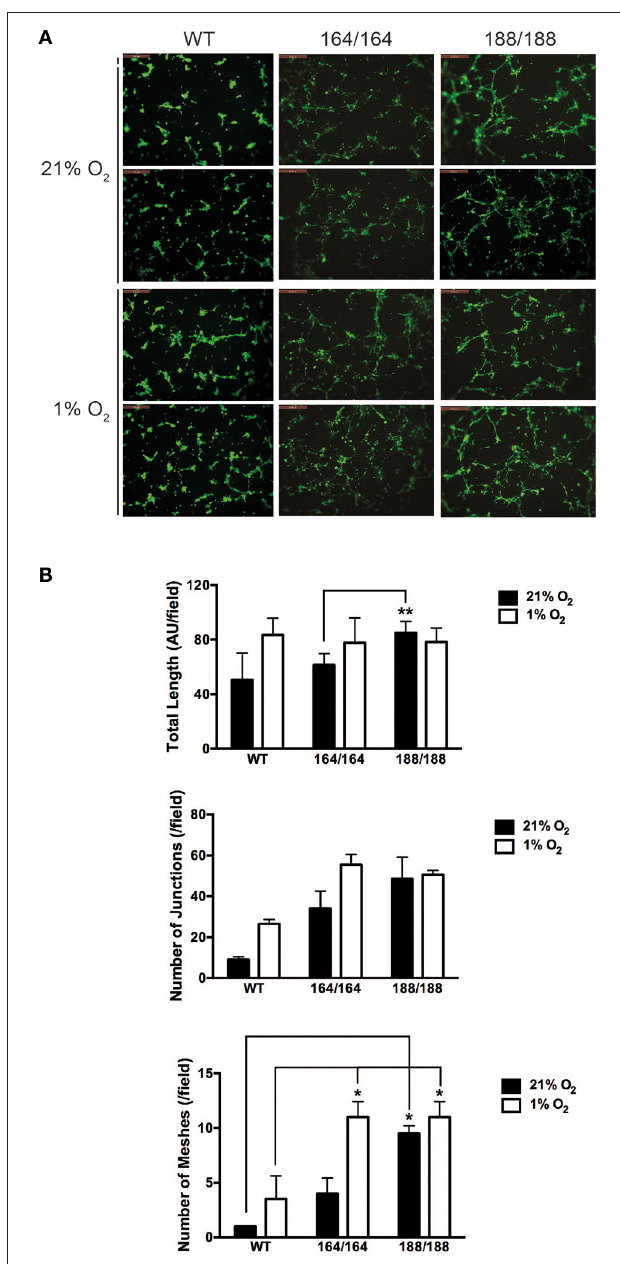
FIGURE 3 | VEGF isoform contribution to endothelial network formation. (A) Tube formation assay on growth factor-reduced Matrigel. Cells were incubated for 9h in 21% O 2 or 1% O 2 and resulting networks were visualized with Calcein AM live cell staining. Scale bars, 500 µ m. (B) Quantification of different parameters of endothelial networks by Image J software, shown as average ± SEM ( n = 3); three fields, each group of cells obtained from 2 to 3 mice. * P < 0.05, ** P <